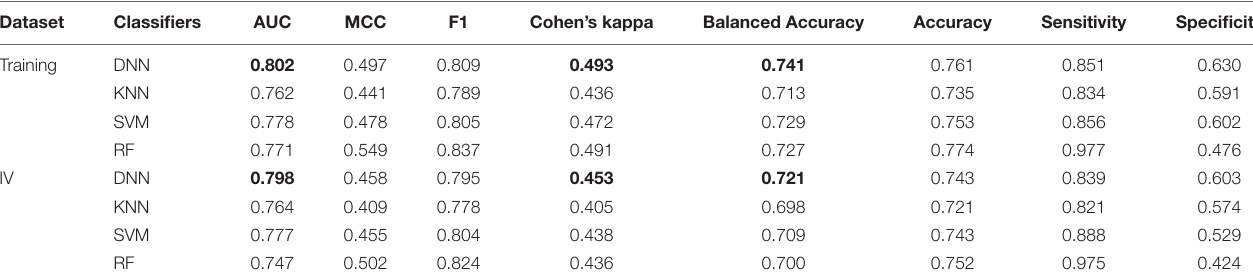
TABLE 1 | Performance for four different classifiers with optimized hyperparameters.